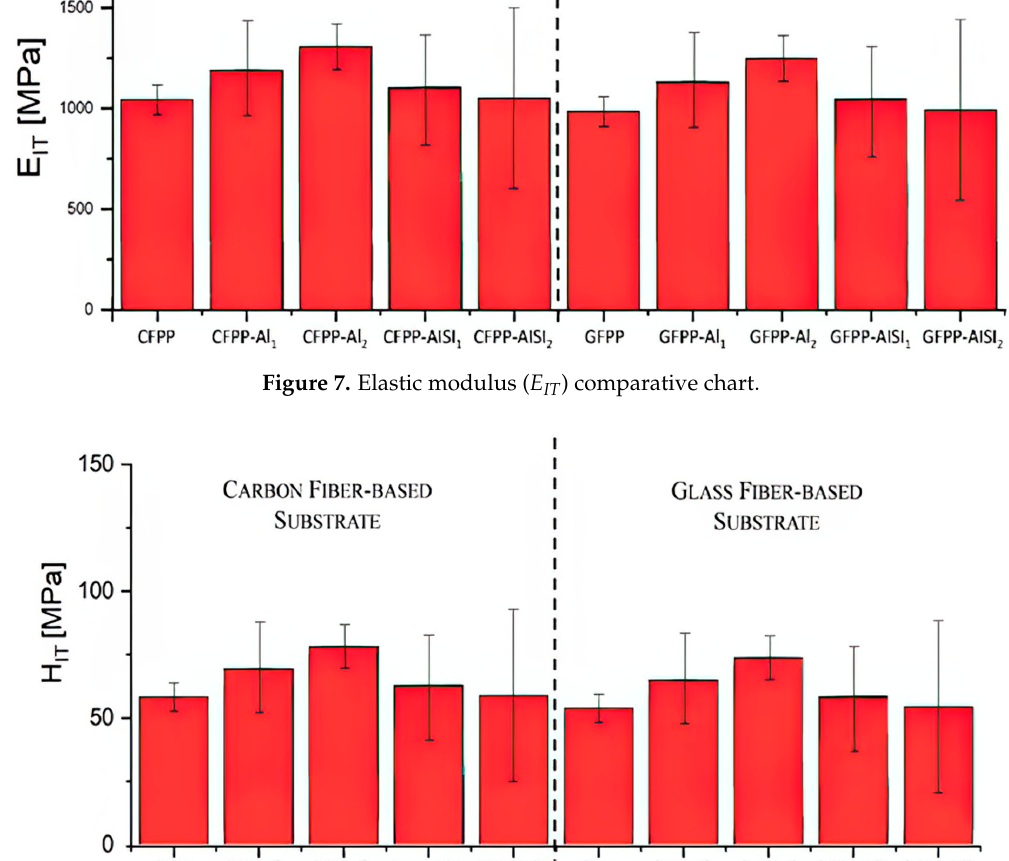
Figure 8. Hardness ( H IT ) comparative chart.